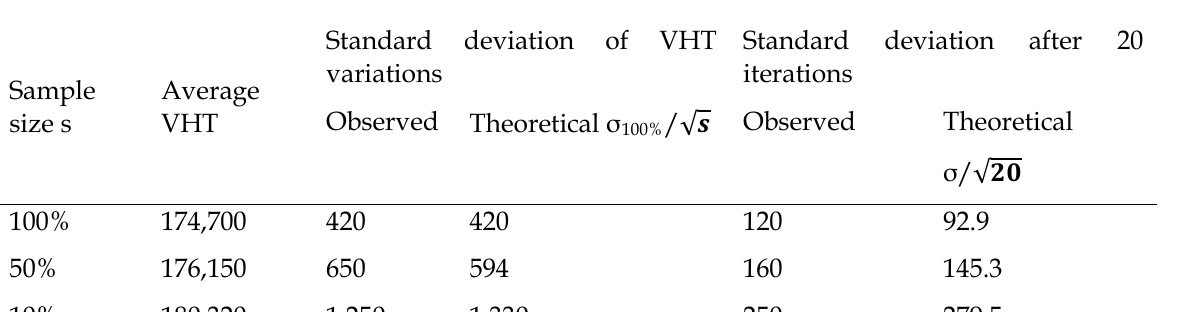
Table 3. Convergence of ABM for different sample